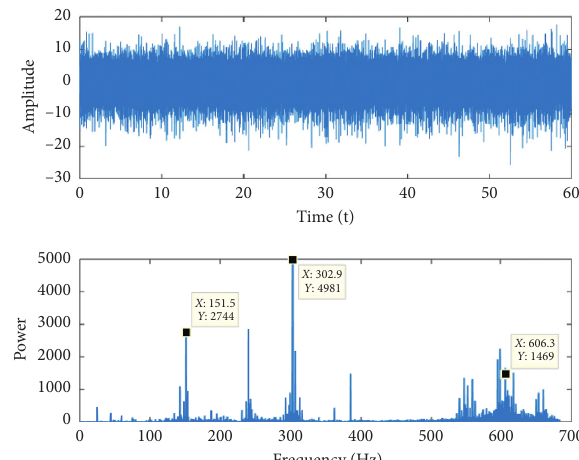
Figure 19: Time domain and frequency domain diagram for signal of pitting gear tooth.